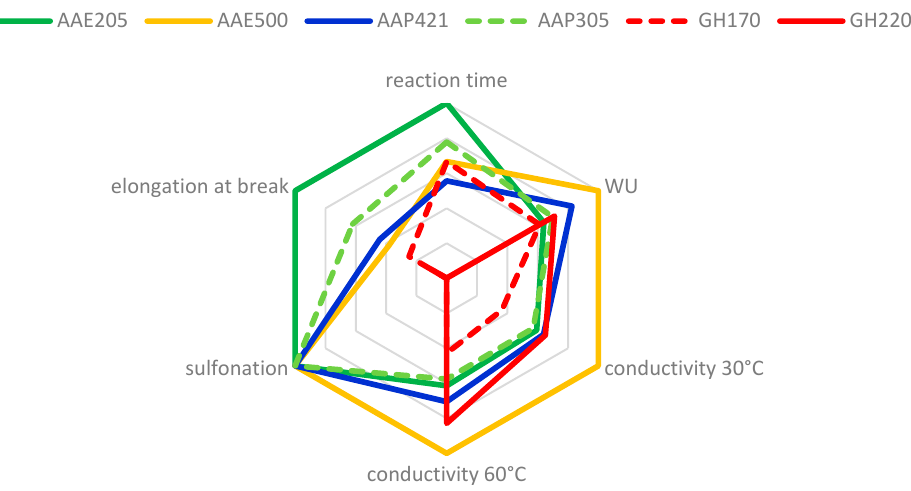
Figure 5. Radar diagram for important aspects related to PEM preparation and properties with the center being the least favorable and the outer circle being the most desirable condition. Further details are given in the main text.